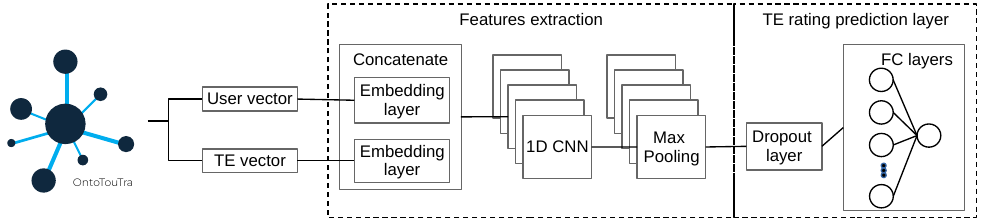
Figure 9. Collaborative Filtering based on 1D CNN and FC